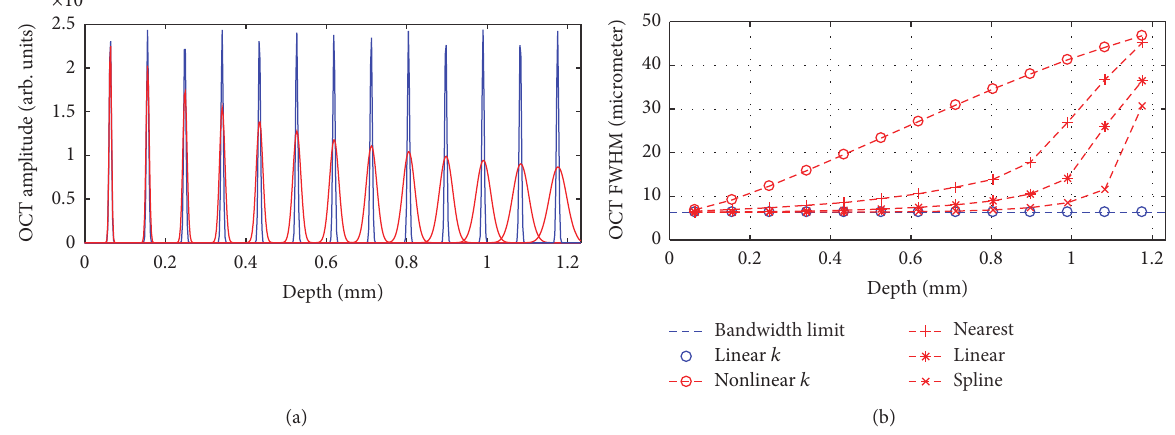
Figure 3: (a) OCT signal acquired with linear 𝑘 (blue) and nonlinear 𝑘 (red). (b) OCT axial PSF FWHM for different spectral interpolation algorithms. The lines are a guide to the